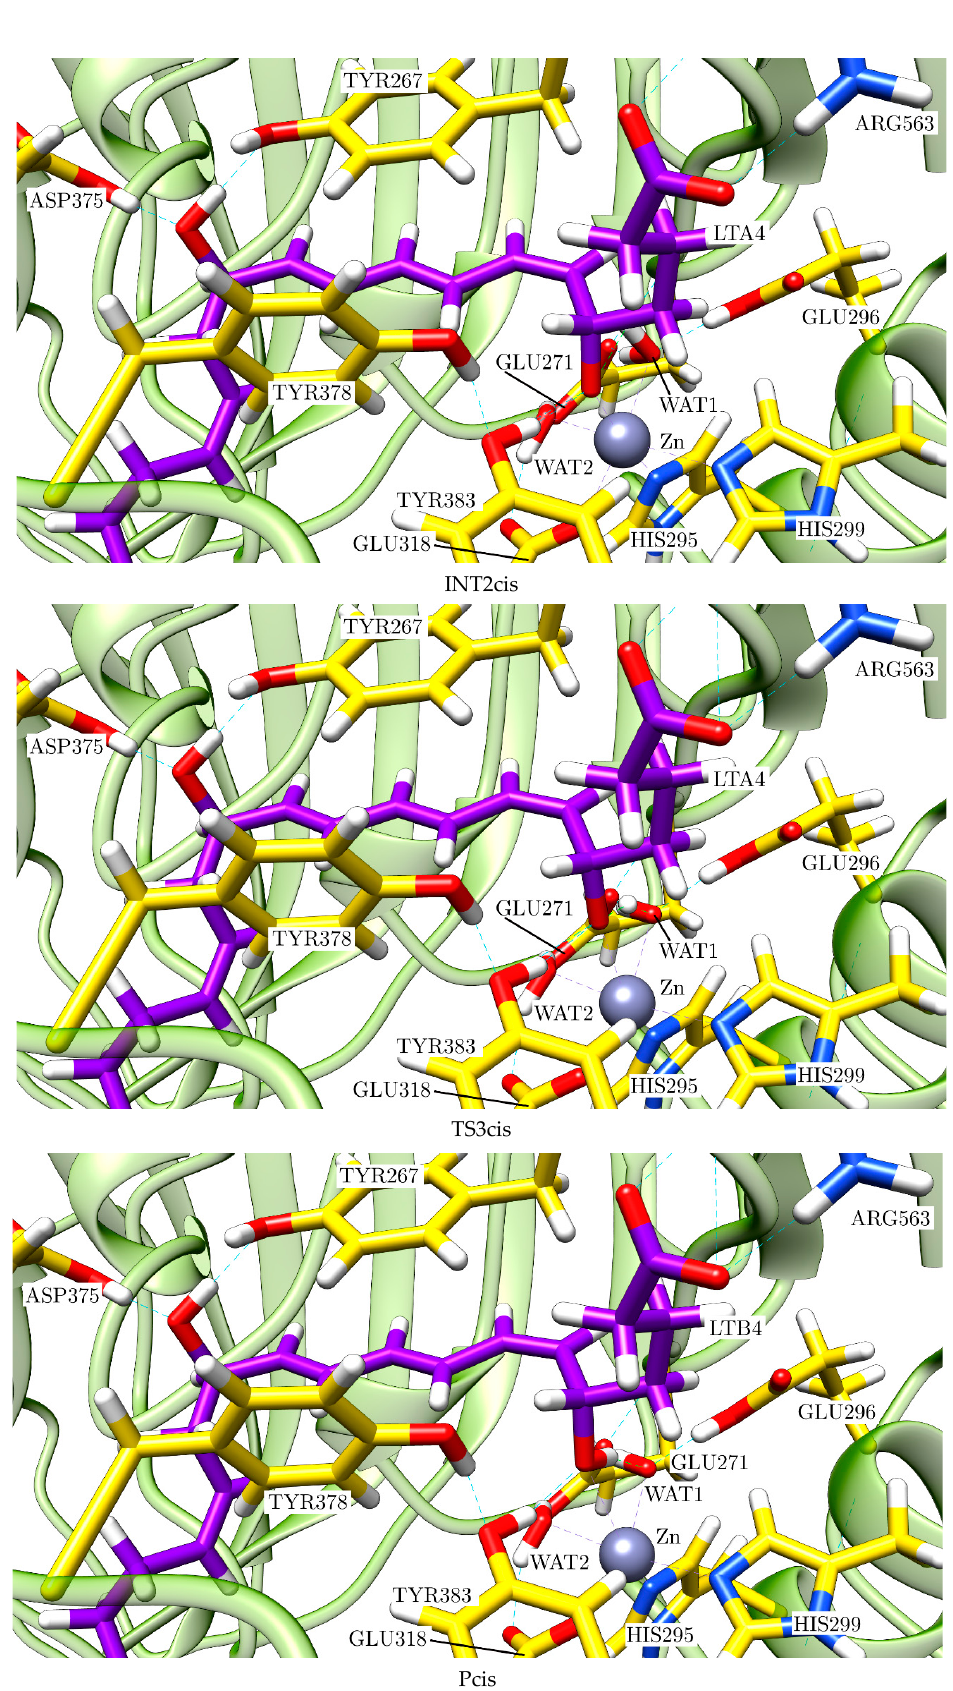
Figure 13. Stationary structures of the complete mechanism of conversion of LTA 4 to LTB 4 (pro- cis reaction path) catalysed by LTA 4 H: R, TS1cis, INT1cis, TS2cis, INT2cis, TS3cis and Pcis. The evolution of the main geometrical parameters along the pro- cis reaction path leading to LTB 4 is indicated in Table 1. As indicated above, the first step consists of the epoxide opening. The formation of a nascent negative charge in the oxygen of the epoxide is stabilised by the interaction of this oxygen with the Zn atom, the hydroxyl group of TYR383 and the hydrogen bond interaction with WAT2 and WAT1, although WAT1 moves away from INT1cis. Conversely, the Zn-O epox bond is significantly shortened from 3.39 Å in R to 1.99 Å at INT1cis, in such a way that epoxide completes the coordination sphere of Zn by occupying its free vacancy (see Figure 5). The epoxide is fully opened at INT1cis, while O epox − C 5 is stronger at INT1cis than in R. This step implies a potential en- ergy barrier of 11.6 kcal/mol. As explained above, at INT1cis no significant changes have occurred with respect to WAT3 and ASP375 yet, thus indicating an S N 1 mechanism. Very interestingly, the dihedral angle H 6 -C 6 -C 7 -H 7 goes from − 65.6° in R (a value close to an intermediate situation of the bond C 6 -C 7 between pro- cis and pro- trans ) to − 15.9° at TS1cis and − 7.1° at INT1cis, a clearly cis stereochemistry. As a result of the twist that the triene moiety must perform to adopt this cis stereochemistry, WAT3 becomes ready to attack the R face of C 12 (by the side opposite to the Zn atom, see Figure S2) at INT1cis. Then, WAT3 adds to C 12 (the distance O(WAT3)-C 12 evolves from 3.69 Å at INT1cis to 1.53 Å at INT2cis), while one of its hydrogen atoms is fully transferred to ASP375 through the corresponding hydrogen bond. This second step involves a potential energy barrier of 15.9 kcal/mol. Fi- nally, in the third step, the final transfer of a proton from WAT1 to the oxygen atom bonded to C 6 (the former oxygen atom of the epoxide, O epox ) takes place, while the distance Zn-O epox clearly increases through a potential energy barrier of 14.4 kcal/mol, thus forming LTB 4 . Note that Haeggström and coworkers [18] have proposed that the catalytic water WAT1 transfers a proton to promote an S N 1 acid-induced opening of the epoxide ring. However, we have found here that this proton donation is not the first step of the reaction, but the last one. That is, when the epoxide ring opens, the nascent negative charge in its oxygen atom is quite stabilised through the interaction with atoms surrounding it, in such a way that a previous proton transfer from WAT1 is not needed.